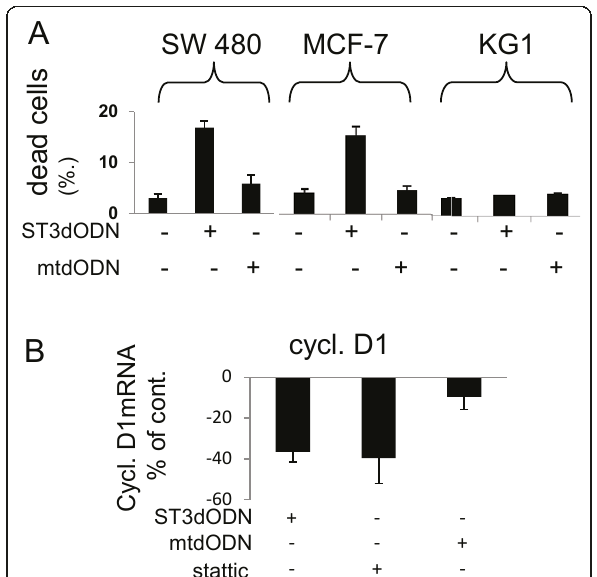
Figure 4 Correlation of STAT3 nuclear translocation inhibition and cell death induction . A : Cell death induction in STAT3-decoy ODN-transfected (2 μ g/ml) SW 480 and MCF-7 cells, controls: no addition, mutated STAT3-decoy ODN (mtODN, 2 μ g/ml); resistance of the acute myeloid leukemia cells KG1 to STAT3-decoy ODN (2 μ g/ml), controls: non-transfected and mutated STAT3-decoy ODN (mtODN)-transfected (2 μ g/ml) cells. Dead cells, incorporating trypan blue, were counted using the V-cell apparatus. Values are expressed in % of dead cells. B : Expression of cyclin-D1 in non-transfected, STAT3-decoy ODN-transfected (2 μ g/ml), Stattic-treated (20 μ M), and mutated STAT3-decoy ODN-transfected (2 μ g/ml) SW 480 cells. Expression was measured using qPCR. Data, normalized using cyclophilin expression ( ΔΔ ct), are expressed as % of control.